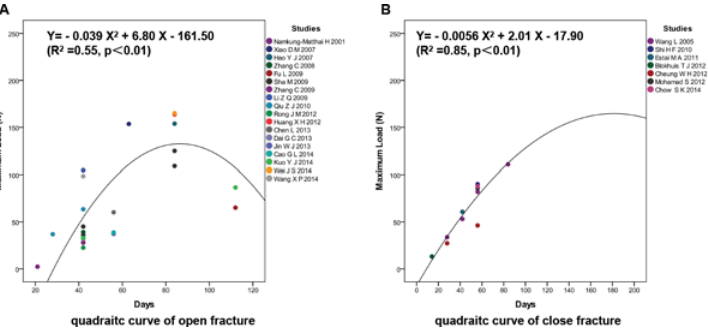
Fig 4. Osteoporotic fracture healing was delayed in OVX rats with closed fractures. (A) In the quadratic curve of open femur fracture, the predicted maximum load was 134.91 N and the predicted fracture healing time was 87.2 d. (B) In the quadratic curve of closed femur fracture, the predicted maximum load was 162.47 N and the predicted fracture healing time was 179.5